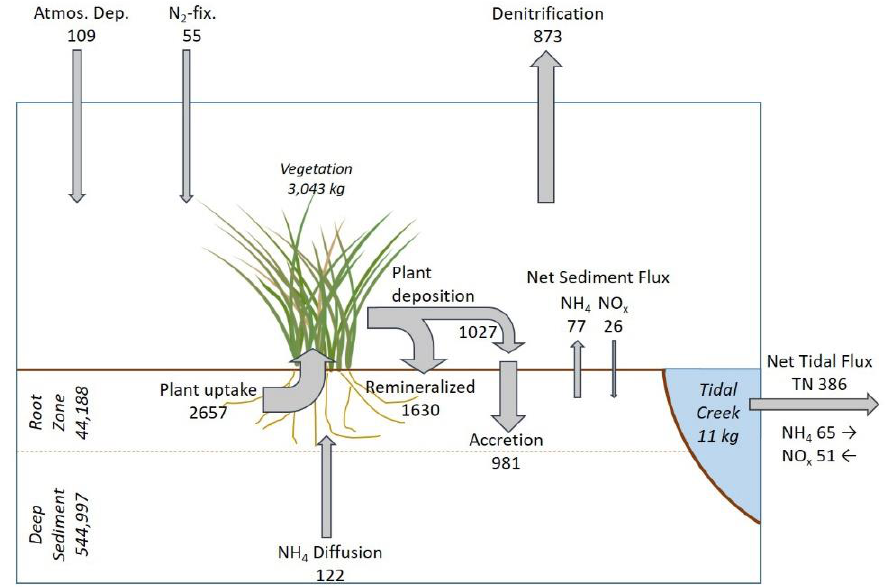
Figure 7. Conceptual diagram of estimated annual N fluxes (kg y − 1 ) in the Cell 1B marsh. Fluxes and standing stocks are shown in normal and italic fonts, respectively. The vegetation standing stock includes both live and standing dead macrophytic vegetation and respective tissue N concentrations, measured in September 2014. Annual plant uptake is based on the live standing stock and plant tissue N estimates. Estimates for remineralized and accreting N from plant organic matter were derived from the annual macrophyte production (plant uptake) and a two-year litter bag (decomposition) study. Estimates of the net sediment fluxes, denitrification and N 2 -fixation were based on direct measurements in marsh platform and tidal creek sediments, weighted for area. Atmospheric deposition was scaled from regional deposition estimates, and NH 4 diffusion was estimated based on measured pore water NH 4 concentration profiles and sediment properties. Arrow width indicates relative flux magnitude, but elements of the diagram are not necessarily to scale. Plant image source: Integration and Application Network (ian.umces.edu/media-library).